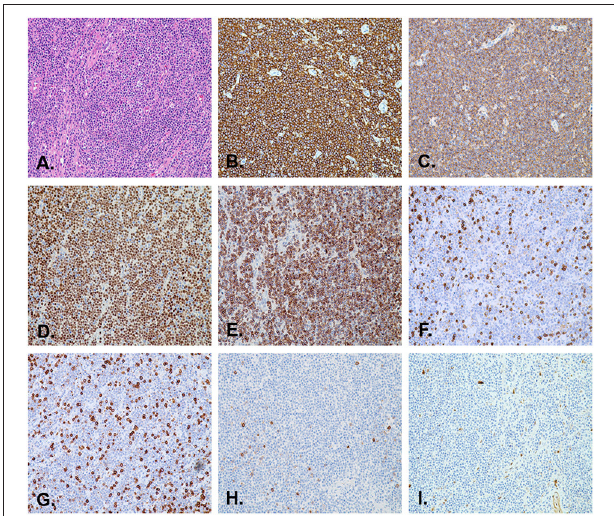
FIGURE 4 | Pathological images of the resected specimen. (A) The histological section shows lymphoid hyperplasia in the lamina propria and submucosa (H&E stain, orig. mag. × 200). Immunohistochemistry revealed that the lymphoma cells are positive for CD20 (B) , CD19 (C) , PAX5 (D) , and BCL2 (E) , and negative for CD3 (F) , CD5 (G) , CD10 (H) , and cyclin D1 (I) (orig. mag. ×